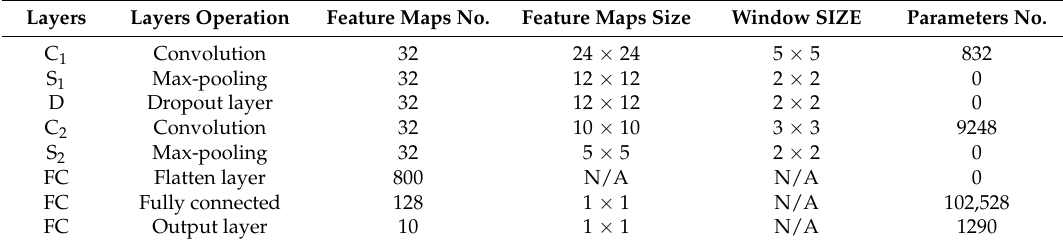
Figure 4. Convolutional neural network (C: convolutional layer, S: sub sampling layer, FC: fully connected layer, F: filters, K: kernels, MP: MaxPooling). Table 1. CNN Parameters setup.